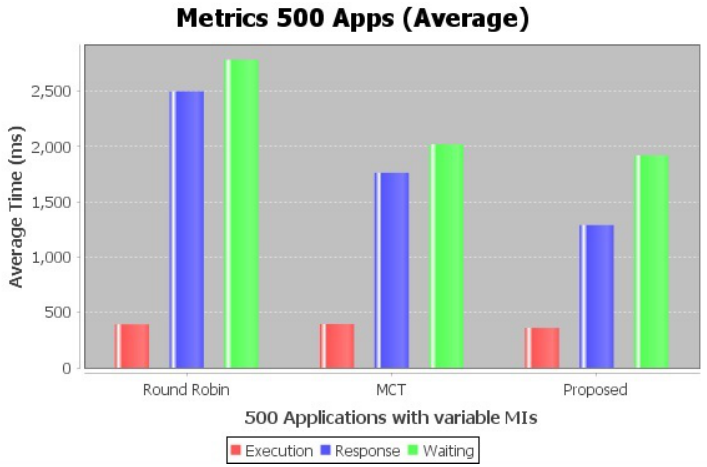
Figure 17. Application (500) performance at local (DC)